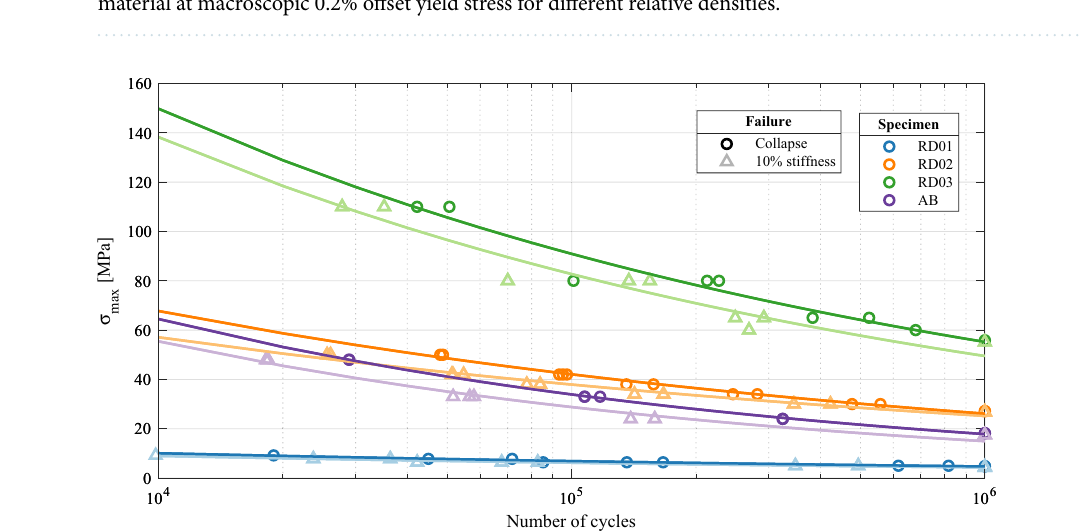
Figure 10. S–N curves of FCCm lattice structures for two different failure